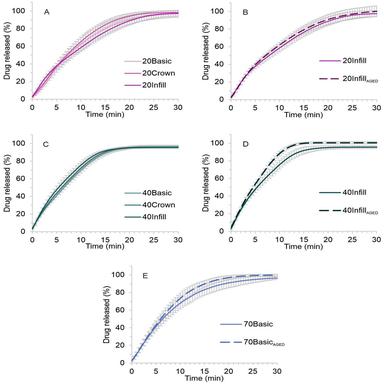
Drug dissolution profiles of fluconazole from 3D printed tablets (n = 3).